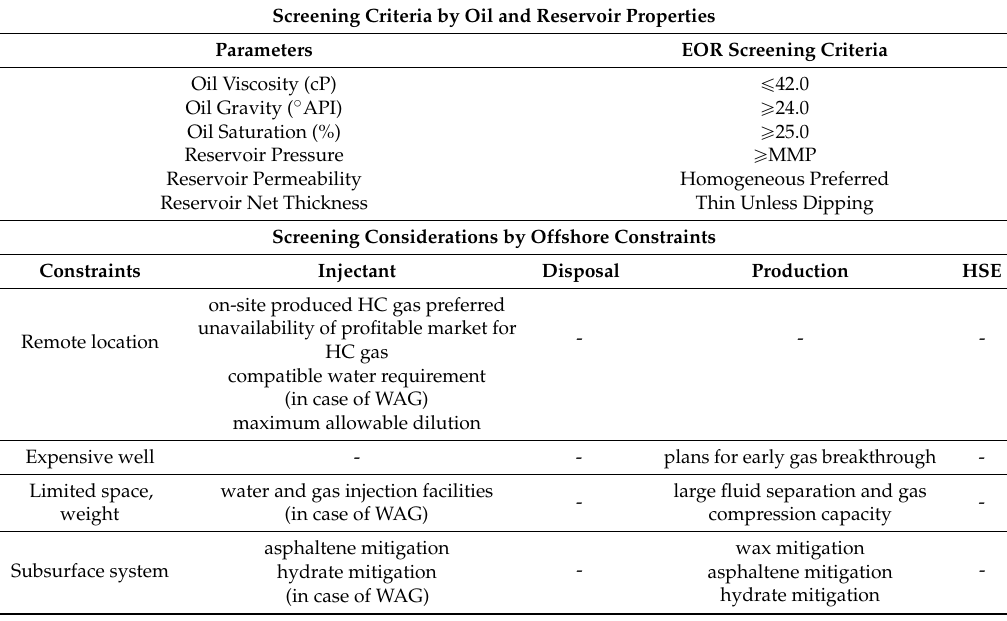
Table 3. New screening criteria for the HC gas miscible